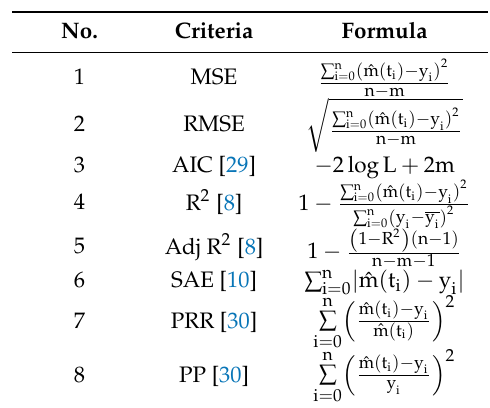
Table 2. List of criteria for model comparisons. MSE (mean squared error), RMSE (root mean squared error), AIC (Akaike’s information criterion), R 2 (correlation index of the regression curve